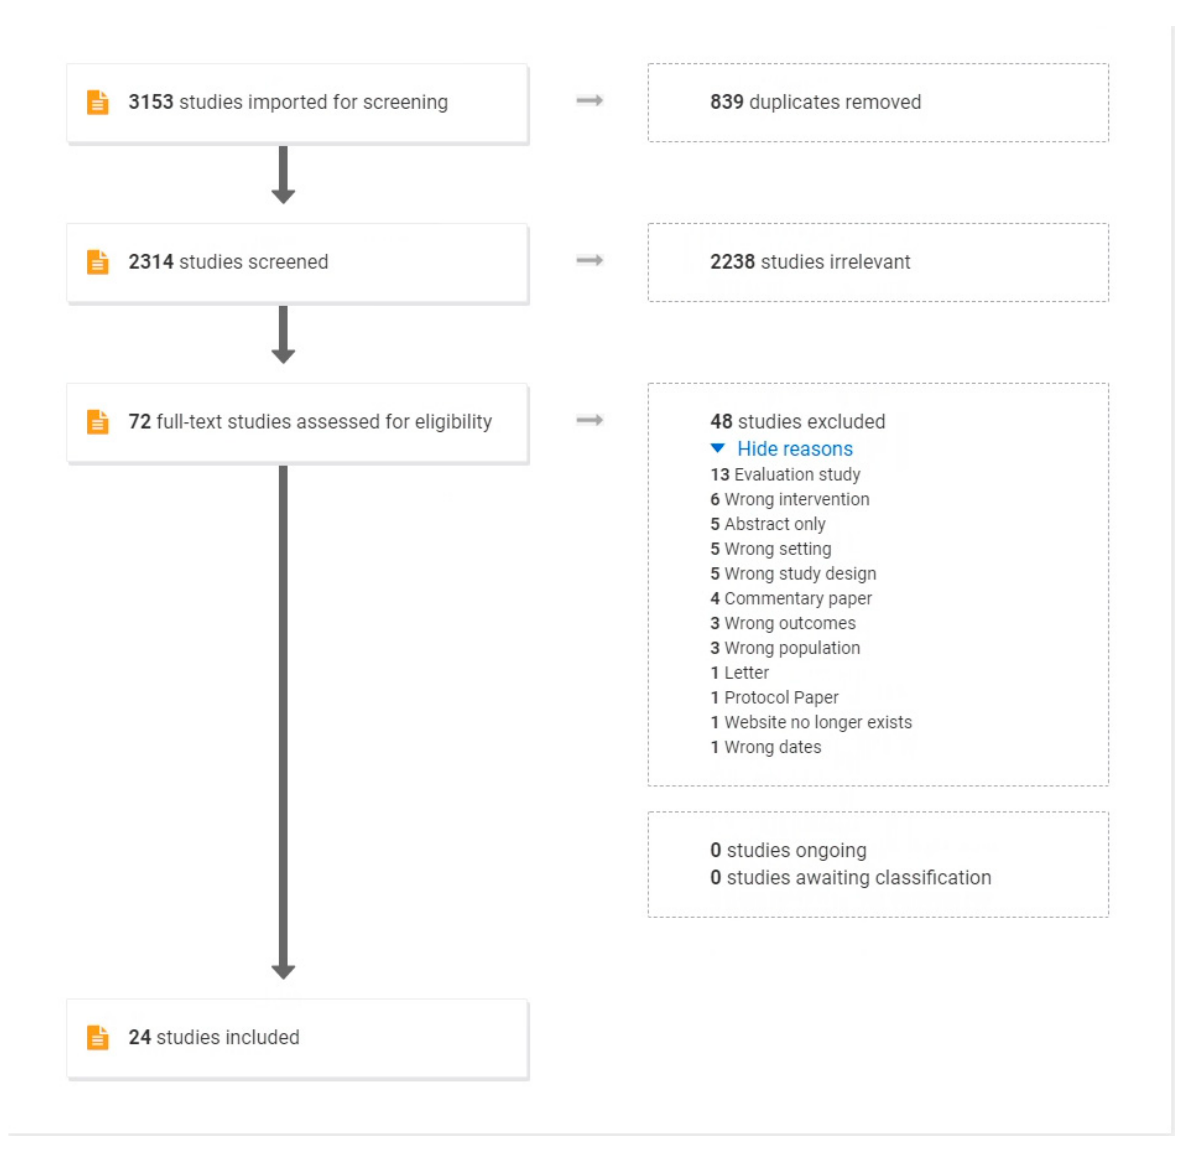
Figure 1. PRISMA Diagram of Scoping Review Results for VCoPs in healthcare.